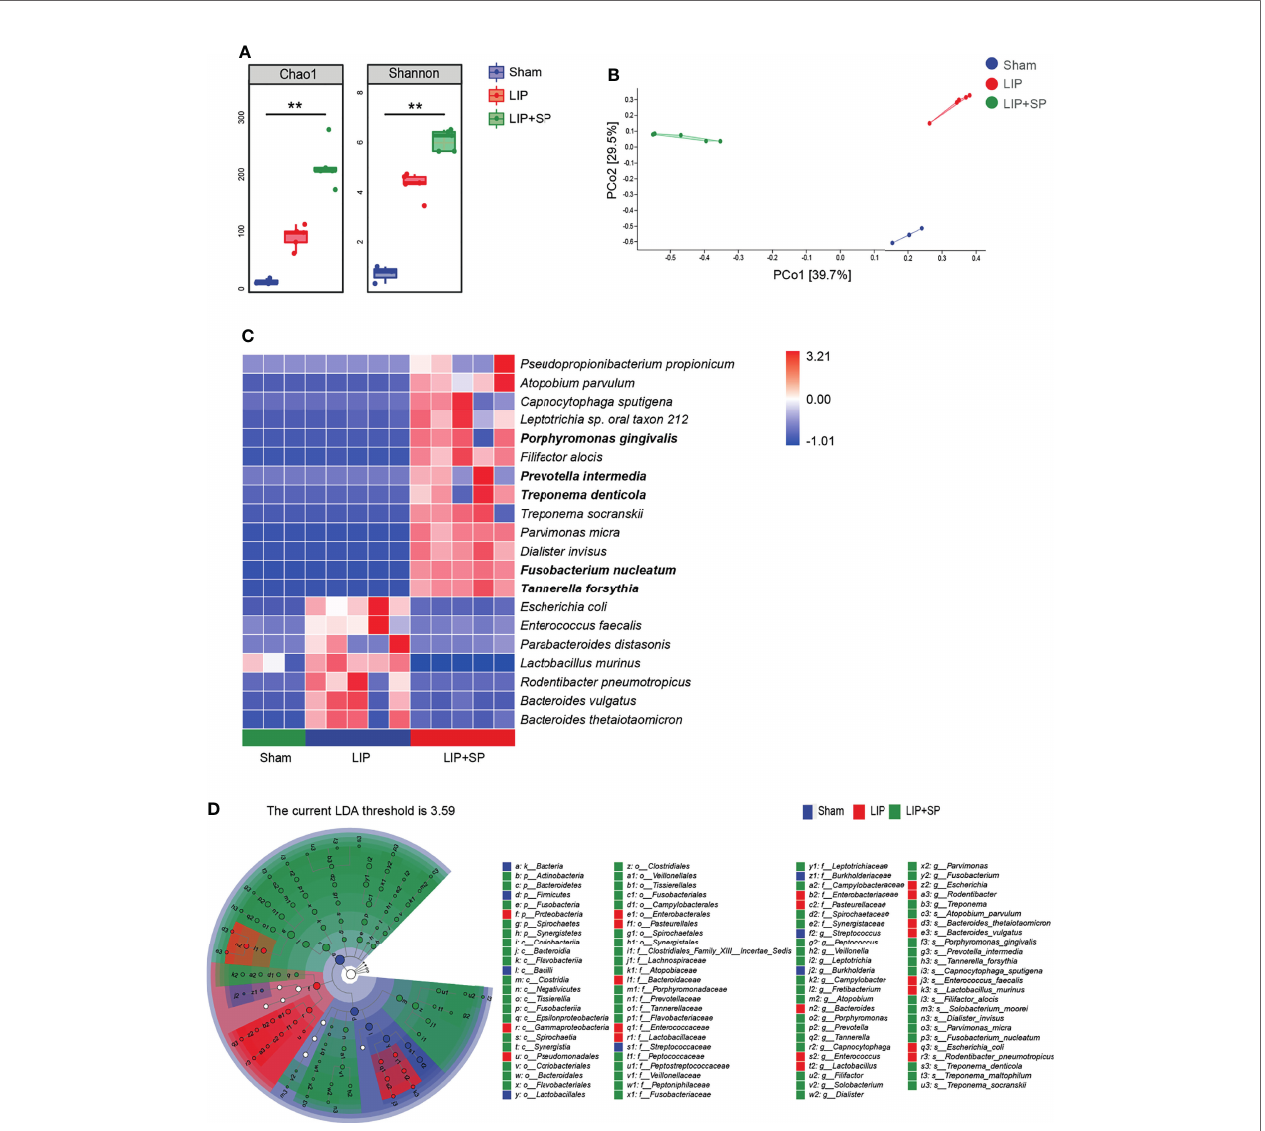
FIGURE 2 | Pathogenic bacteria of human periodontitis are enriched in the ligature silk in the mouse model. Bacterial community of ligature silks from Sham, LIP, and LIP + SP group mice were analyzed using 16S rRNA gene sequencing. (A) a -diversity of bacteria on ligature silks assessed by Chao1 and Shannon indices. (B) b -diversity of bacteria on ligature silk assessed by principal coordinate analysis (PCoA) based on Bray – Curtis distance of bacteria at species level. (C) The heat map of the relative abundance of the top 20 most abundant species of bacteria on ligature silks. (D) Taxonomic cladogram of bacteria on ligature silk using LEfSe (LDA = 3.59). The values represent means ± SEM (n = 3:5:5). **P <